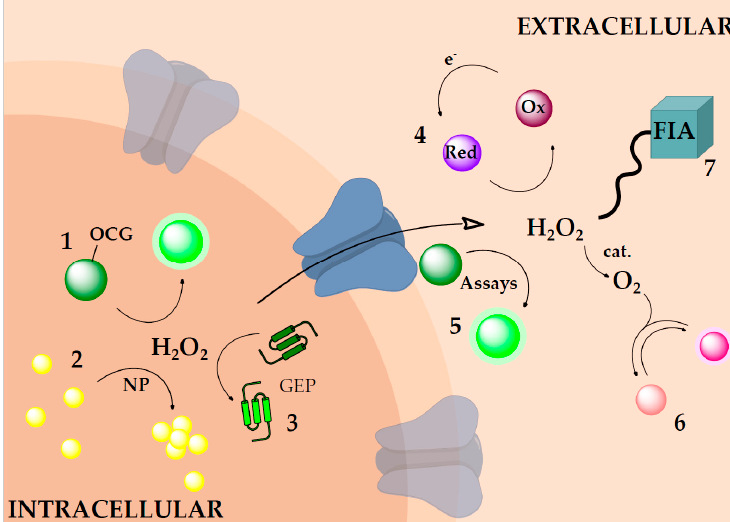
Figure 1. Possible optical H 2 O 2 detection techniques for intra- or extracellular applications. The arrow in the middle indicates the ability of H 2 O 2 to diffuse out of the cell e.g., via an aquaporin-mediated mechanism. ( 1 ) An oxidative cleaving group (OCG) is irreversibly cleaved; the product emits fluorescence after excitation with an external source; ( 2 ) Intracellular application of nanoparticles (NP), where the irreversible oxidation of NP forms an aggregate with changed optical properties; ( 3 ) Genetically encoded proteins (GEP) for selective H 2 O 2 measurements; ( 4 ) Redox system being oxidized by H 2 O 2 and reduced by an external reducing agent; ( 5 ) Luminescence assays for extracellular H 2 O 2 determination; ( 6 ) Indirect detection of H 2 O 2 via O 2 measurement. ( 7 ) Flow injection analysis (FIA) with local sampling of extracellular H 2 O 2 for external measurement.